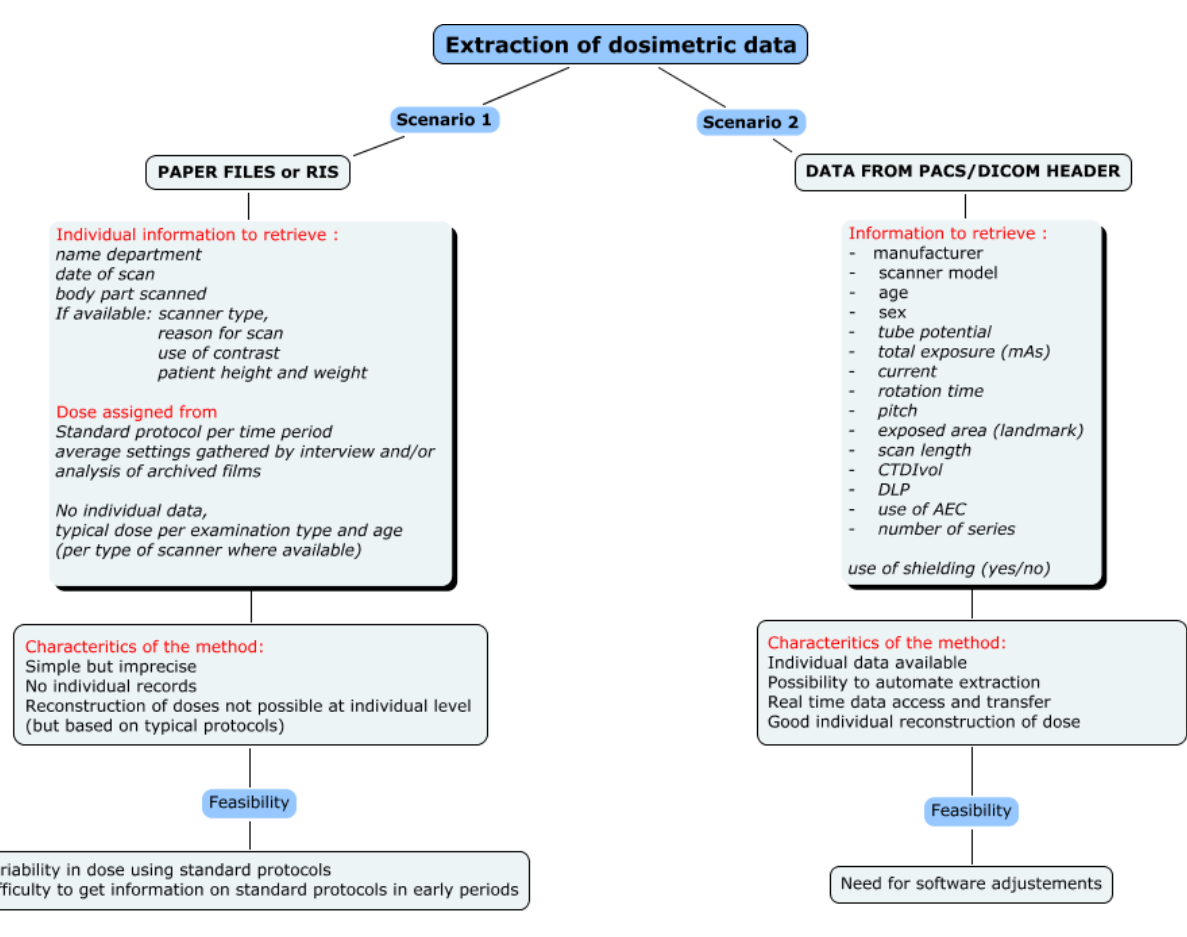
Figure 1. Scenarios for CT dose